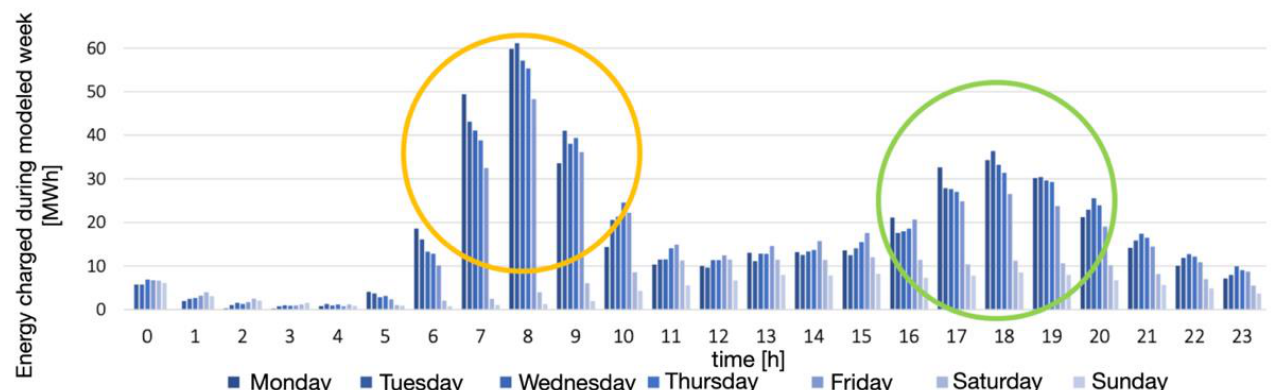
Figure 7. Temporal distribution of the energy charged during the modelled week (30% BEV, new charging points = 50 kW, public charging is possible everywhere).